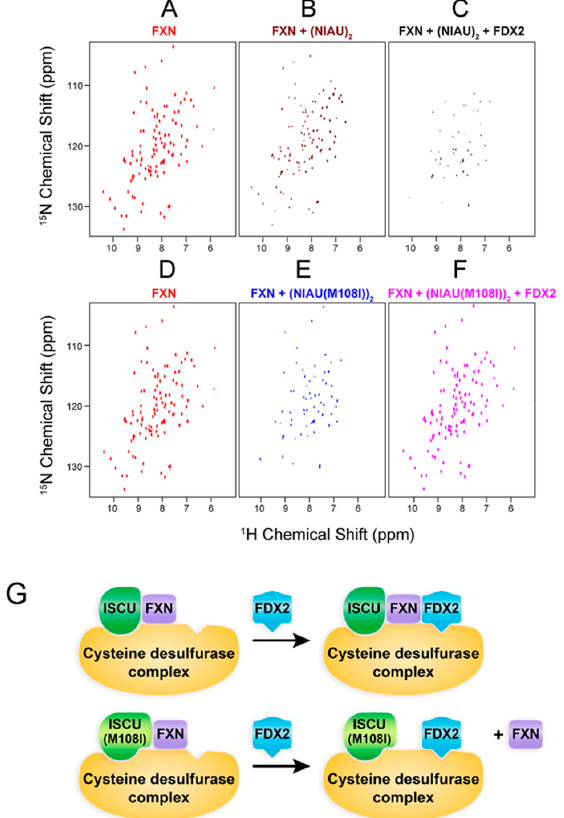
Figure 6. NMR evidence that FDX2 binds to (NIAUF) 2 without displacement of FXN but that FDX2 added to (NIAU(M108I)F) 2 displaces FXN. ( A ) 1 H- 15 N TROSY-HSQC spectrum of [U- 15 N]-FXN; ( B ) 1 H- 15 N TROSY-HSQC spectrum of [U- 15 N]-FXN after the addition of 0.5 subunit equivalent of unlabeled (NIAU) 2 ; ( C ) 1 H- 15 N TROSY-HSQC spectrum of [U- 15 N]-FXN after the addition of 0.5 subunit equivalent of unlabeled (NIAU) 2 and 1.0 subunit equivalent of unlabeled FDX2; ( D ) 1 H- 15 N TROSY-HSQC spectrum of [U- 15 N]-FXN; ( E ) 1 H- 15 N TROSY-HSQC spectrum of [U- 15 N]-FXN after